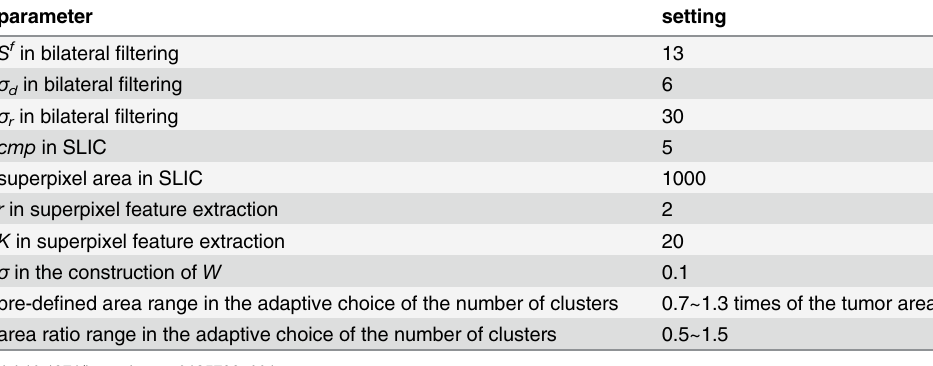
Table 1. Parameter settings of the proposed method in